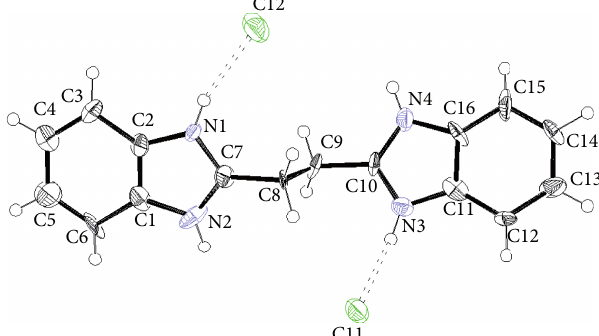
F 4: e molecular structure of compound 1 . Displacement ellipsoids are plotted at the 50 probability level. Hydrogen bonds are shown as dashed %